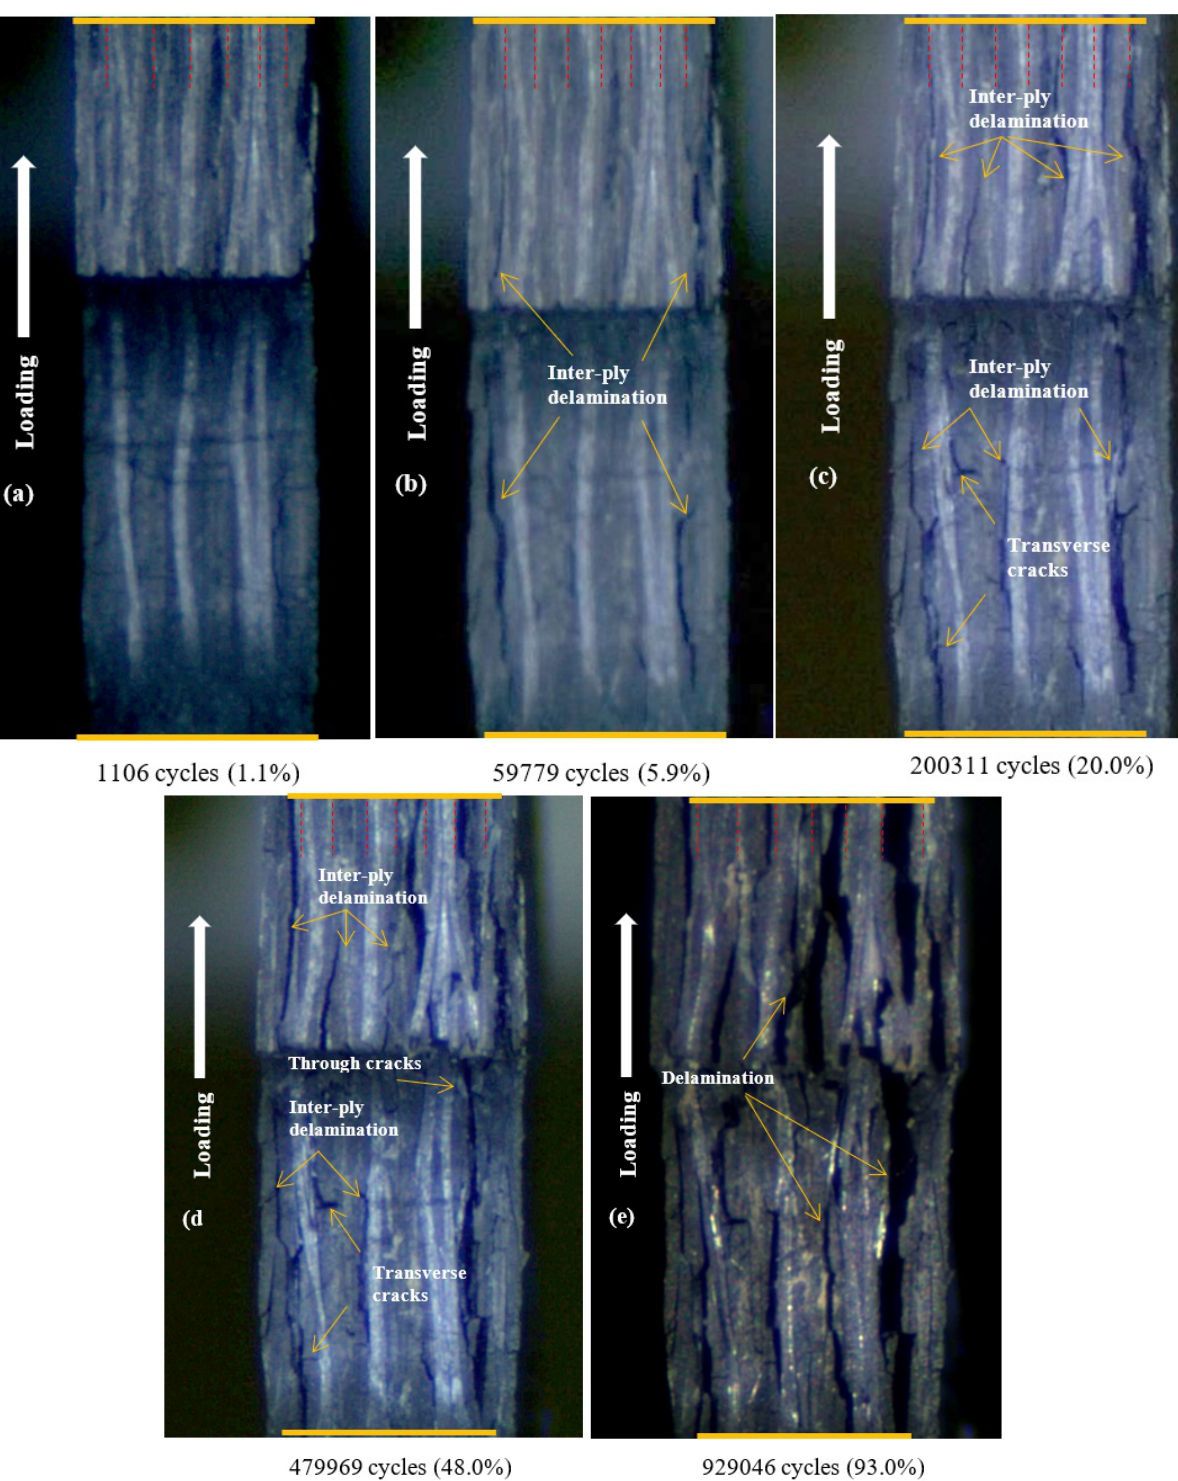
Figure 11: View of the tension-tension fatigue of 3mm depth notched specimen under 90%UTS (a) at 1106 cycles (1.1% of the life); (b) at 59779 cycles (5.9% of the life); (c) at 200311 cycles (20.0% of the life); (d) at 479969 cycles (48.0% of the life); (d) at 929046 cycles (93.0% of the